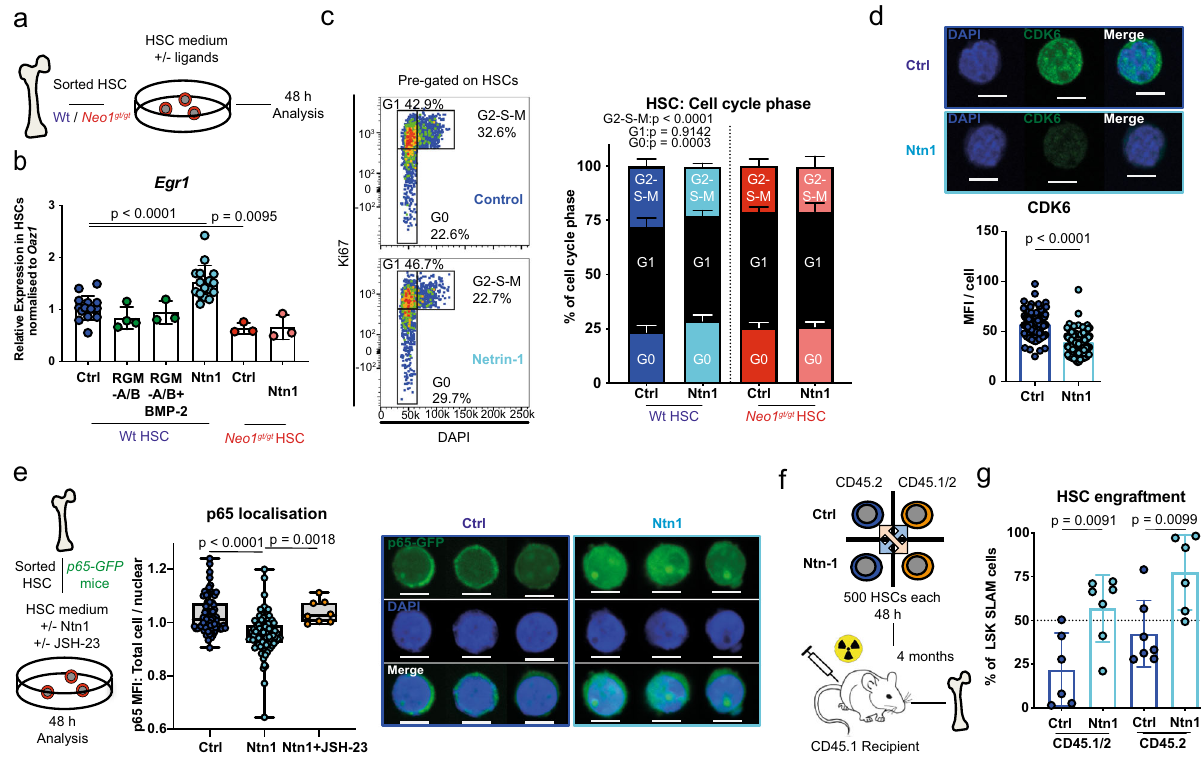
Fig. 5 Ntn1 preserves HSC quiescence and engraftment potential in vitro via Neo1. a Work fl ow: In vitro stimulation of sorted HSCs used in ( b – d ), analysis after 48 h. b Relative expression of Egr1 in Wt HSCs; n = 3 (other), 4 (RGM-a + b), 16 (Ctrl/Neo1), for ctrl/Ntn1, four independent experiments. c Representative cell cycle plots pre-gated on HSCs and quanti fi cation with or without Ntn1 treatment; n = 3 (Neo1), 11 (Wt-Ctrl), 12 (Wt-Ntn1), three independent experiments for ctrl HSC. d MFI of CDK6 in Wt HSCs 48 h after Ntn1 treatment, quanti fi cation of MFI per cell; n = 114 (Ctrl) and 134 (Ntn1). e Work fl ow: representative images and quanti fi cation of total cell/nuclear MFI of p65-GFP HSC 48 h after treatment with Ntn1 or Ntn1 + JSH-23; n = 8 (JSH-23), 78 (Ctrl), 91 (Ntn1), two independent experiments. f Work fl ow: competitive transplantation of Ntn1 stimulated CD45.2 and CD45.1/2 HSCs. g Chimerism of bone marrow LSK-SLAM cells 4 months after competitive transplantation of Control vs. Ntn1-treated HSCs; n = 6 (CD45.1/2), 7 (CD45.2), two independent experiments. For all panels, ±SD is shown. n indicates biological replicates. Scale bars in IF images are 4 μ m. P value was determined by two-tailed t test unless stated otherwise. Source data are provided as a Source Data fi